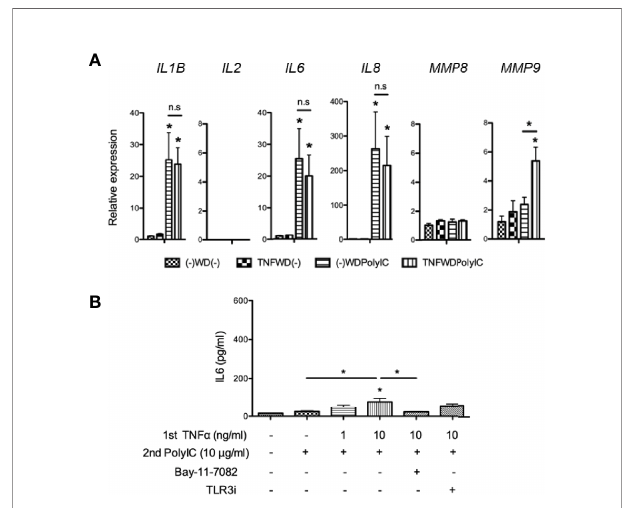
FIGURE 6 | Stimulation of MRC-5 cells using TNF – WD – PolyIC. (A) Gene expressions of IL1B , IL2 , IL6 , IL8 , MMP8 , and MMP9 . Exposure to Poly (I:C) increased the gene expressions of IL1B , IL6 , and IL8 (P < 0.005), but not those of IL2 , MMP8 , and MMP9 [(-)-WD-(-) vs. (-)-WD – PolyIC]. Pretreatment with TNF a did not enhance the cytokine gene expressions. However, MMP9 expression was signi fi cantly increased (P < 0.05) [(-)-WD – PolyIC vs. TNF – WD – PolyIC]. N = 4. (B) IL6 release was signi fi cantly increased upon preexposure to TNF a (10 ng/ml) and secondarily treated with Poly (I:C), However, low levels of IL6 were detected (< 100 pg/ml). N = 4. Values with * were de fi ned signi fi cant when compared to (-)-WD-(-) while *above bar were signi fi cant between two